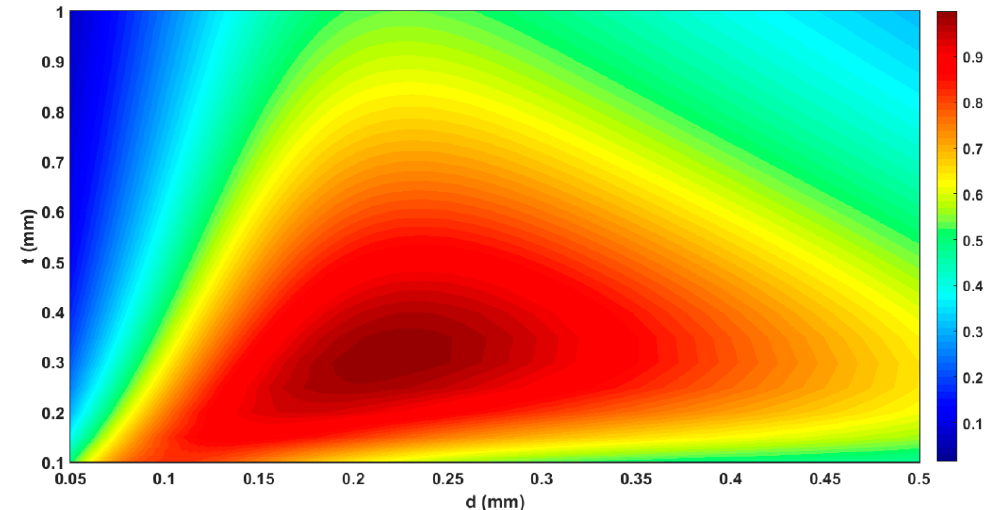
Figure 10. Absorption coefficient of an SL-MPP as a function of ( d , t ) for ( f , φ , D ) = (1500 Hz,1%, 2 cm). Buildings 2019 , 9 , x FOR PEER REVIEW